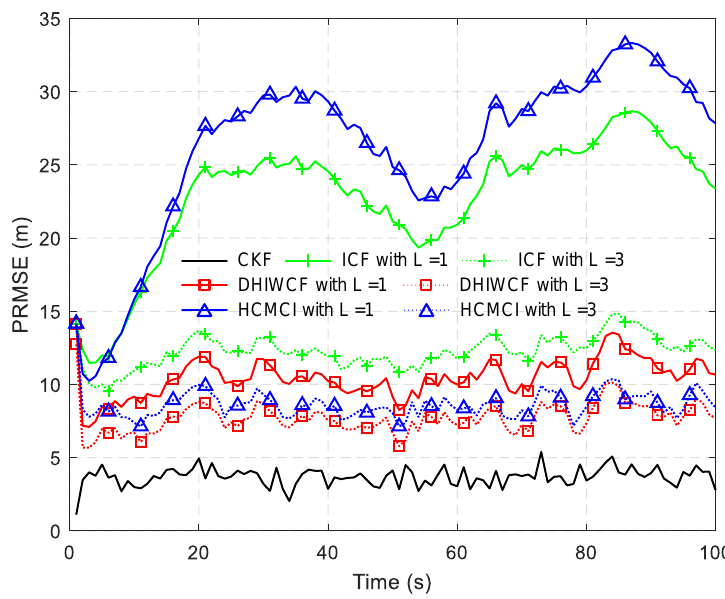
Figure 15. PRMSE for different algorithms in a spare sensor network.